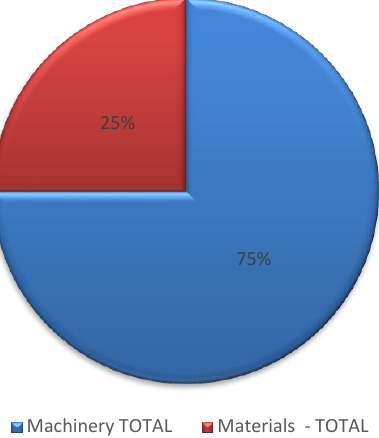
Figure 7. Total greenhouse gases (GHG) distribution in scenario 4.